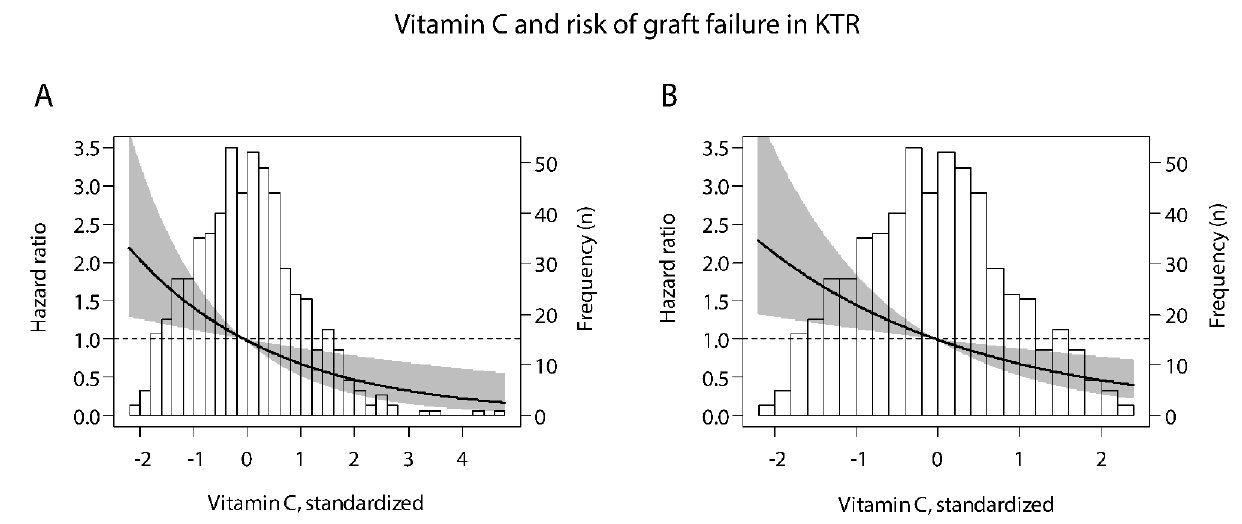
Table S2). Similar results on interaction analyses were found over tertiles of plasma vitamin C (Table 3 and Table S2).